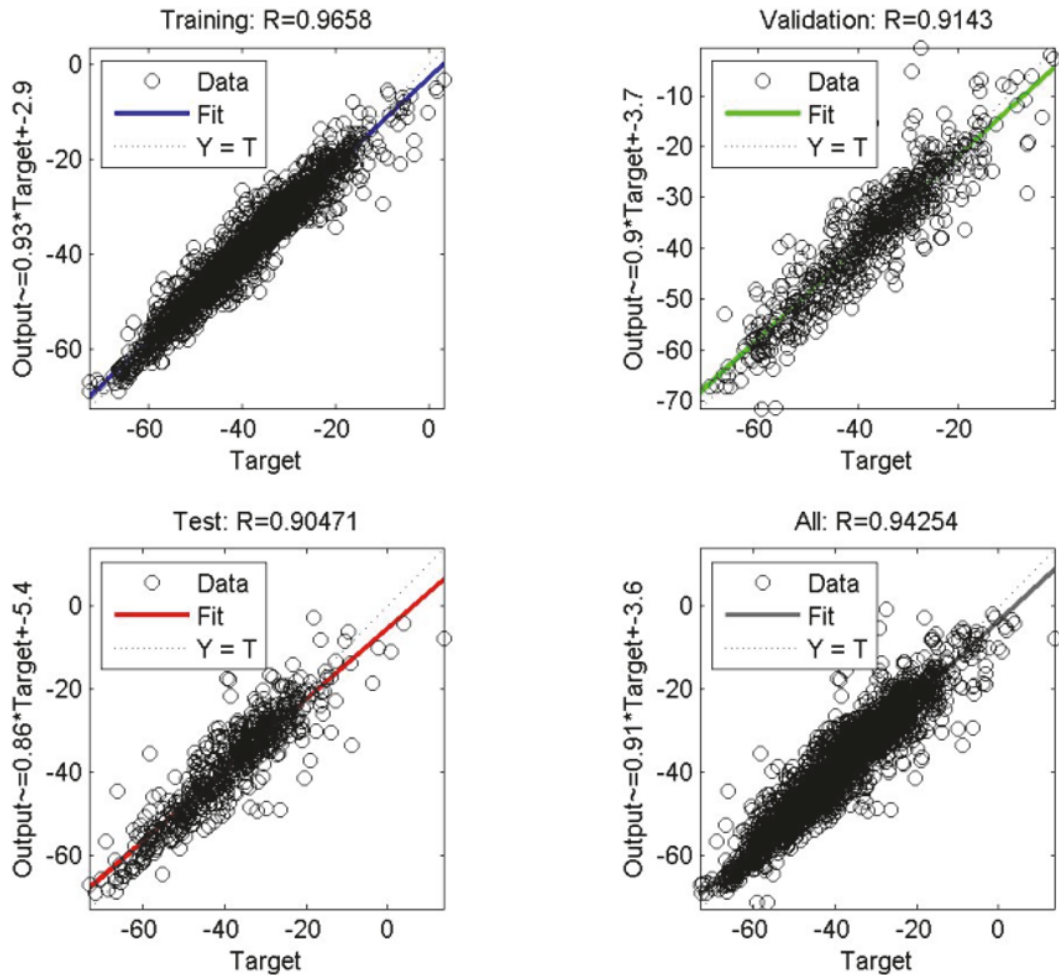
Figure 8: Performance of ANN model for prediction of Bouguer anomalies around Benue trough with 3 inputs.